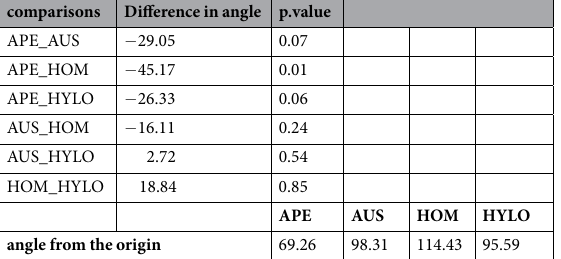
Table 2. Multivariate angle of evolutionary rates. The row names correspond to individual comparisons of one group to another. APE = great apes exclusive of hominins, AUS = australopiths, HOM = Homo species, HYLO = lesser apes. Calculations were performed on the whole numbers, while the table only reports approximated round-down values to